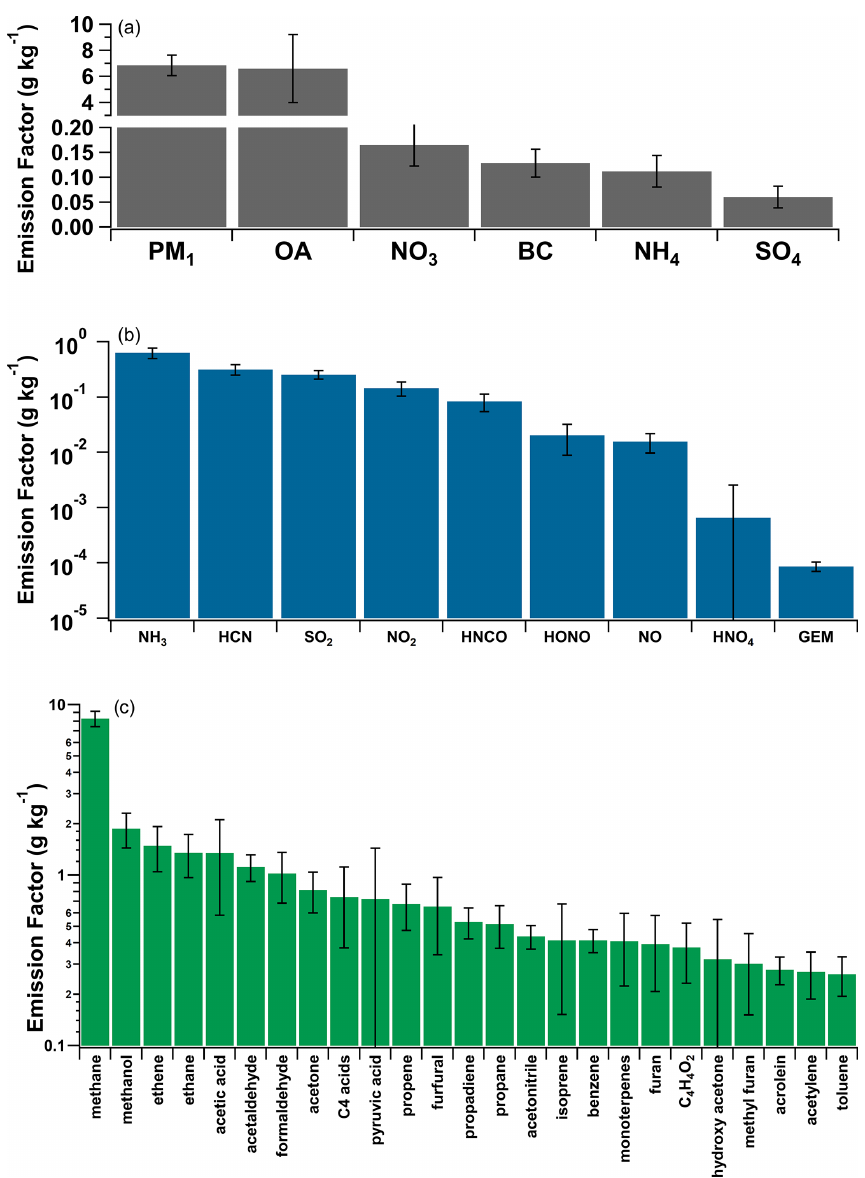
Figure 8. Average emission factors (gkg − 1 ) of (a) particle species, (b) inorganic gas-phase species, and (c) the top 25 measured gas-phase organic species. C4 acids = C4 oxo-carboxylic acids; propadiene = fragments/propadiene; hydroxy acetone = hydroxy acetone/ethyl formate. Organic species measurements are from the PTRMS, CIMS, and